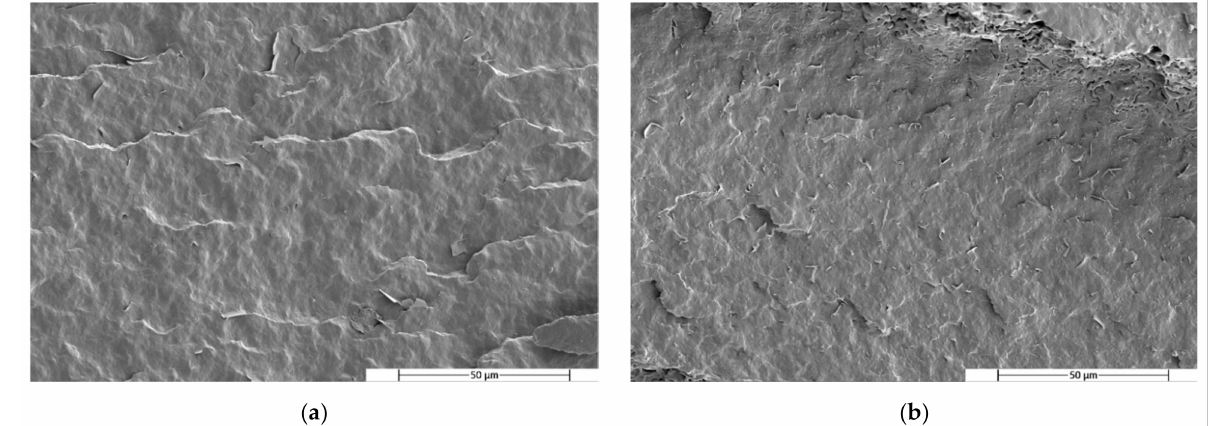
Figure 8. SEM micrographs of fractured surfaces after minor phase solving at 2500 × of ( a ) PHA80PBS20 and ( b ) PHA60PBS40 blends.